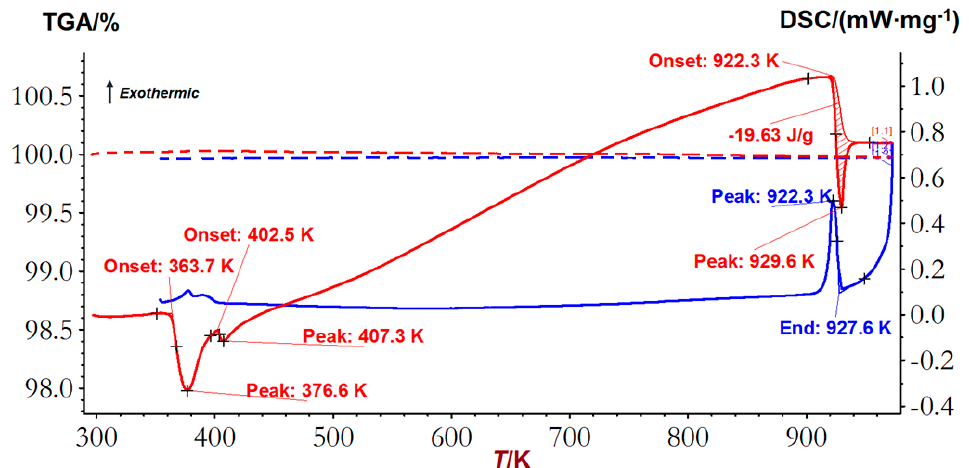
Figure 7. The differential scanning calorimetry (DSC) and thermogravimetric analysis (TGA) curves for the synthesized two phases assemblage (Ag 1 . 2 Cu 0 . 8 S and AgCuS). The red and blue curves represent heating and cooling, respectively. The dashed curves are TGA vs. T and solid curves are DSC vs. T.